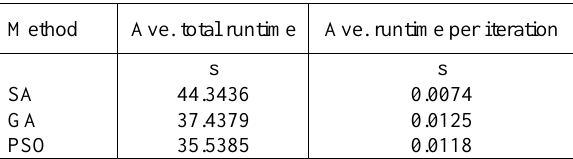
Table 6. Average runtime